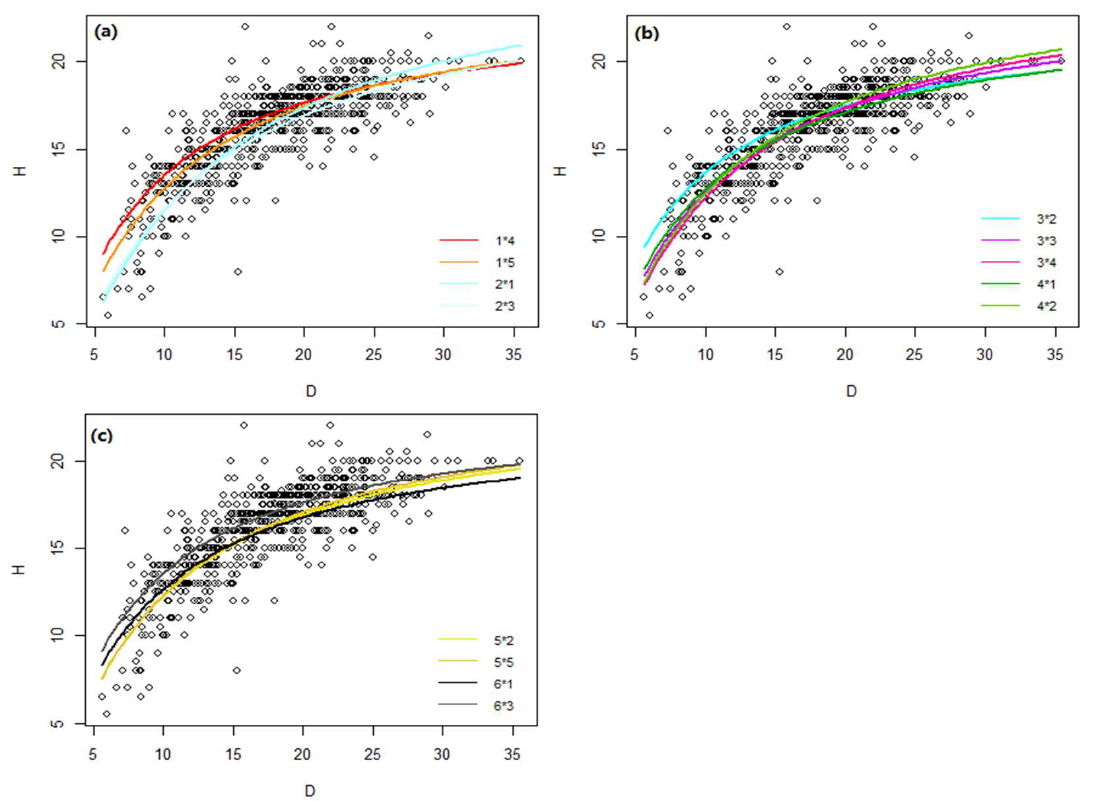
Figure 5. The height-diameter curves produced with Equation (13) corresponding to the different M ∗ S superimposed on full data set. Plot ( a ) described the height-diameter relationship in low-density stands, plot ( b ) described the height-diameter relationship in medium-density stands, and plot ( c ) described the height-diameter relationship in high-density forest stands. (Symbol M ∗ S means stand density ∗ site index; 1 ∗ 4= stand density of the stand is class 1 and site index of the stand is class 4). H= tree height (m); D = diameter at breast height (cm).